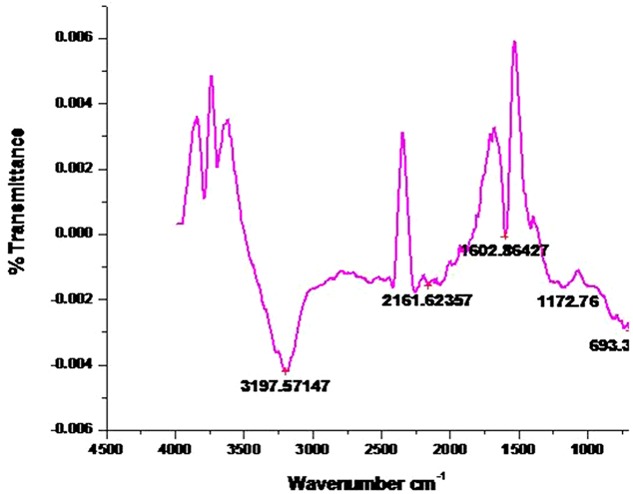
Fourier transform infrared spectroscopy result analysis of AgNPs synthesized by P. serratum leaf.
X-axis represents the spectra (cm-1) and Y-axis represents percent (%) transmission.